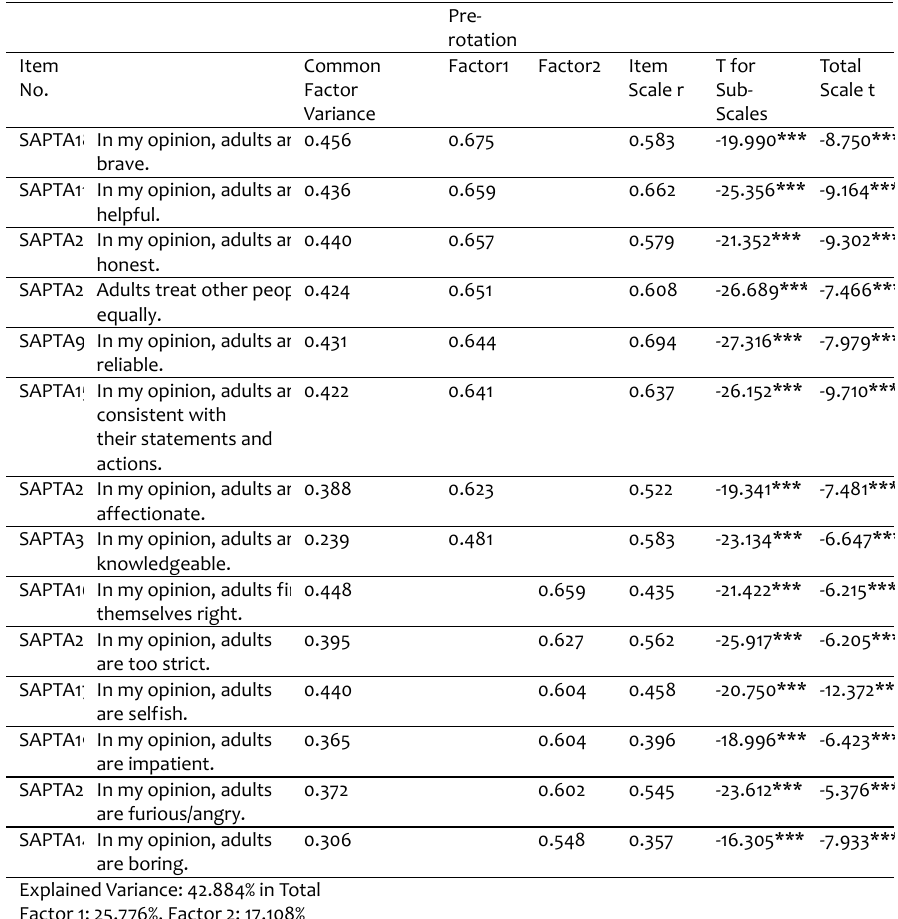
Table 1. Results of SAPTA Factor Analysis Pre-